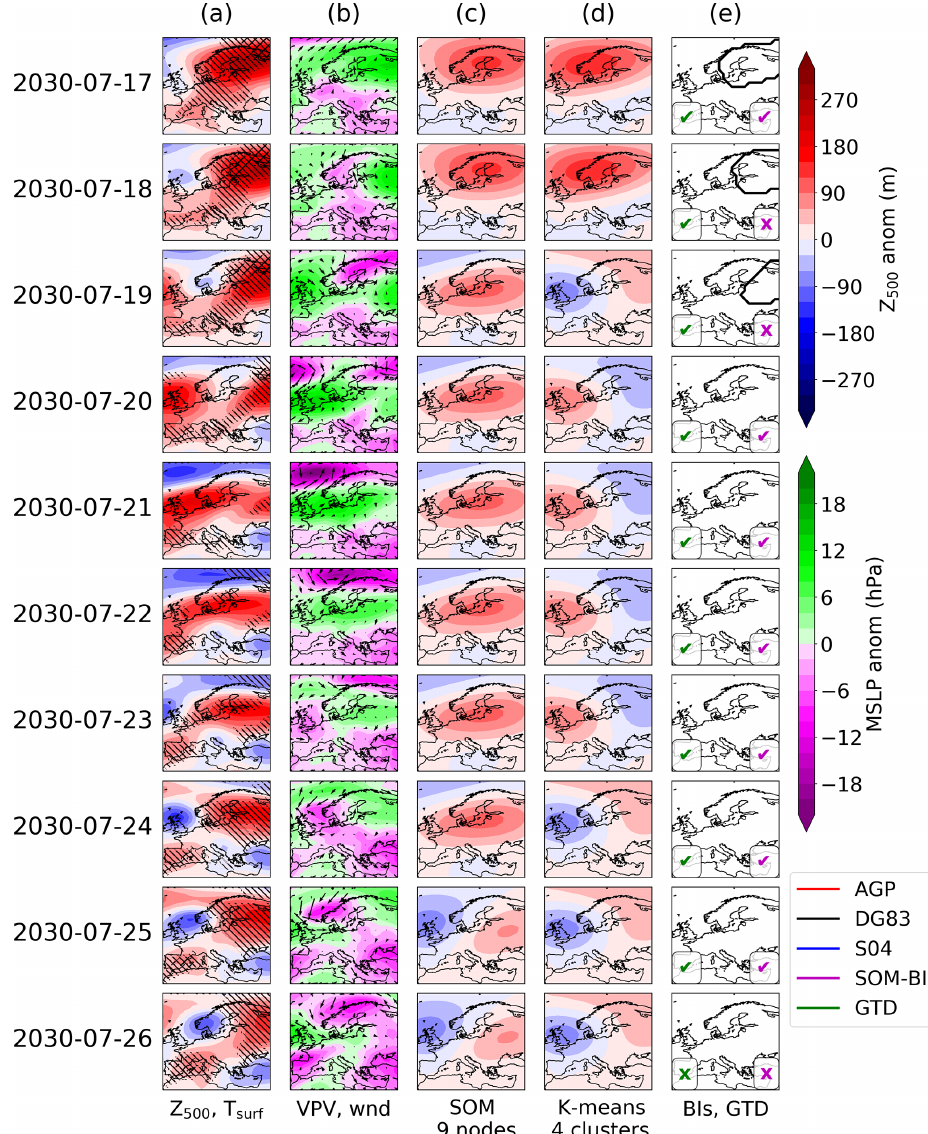
Figure A3. As above, but for a transient period in